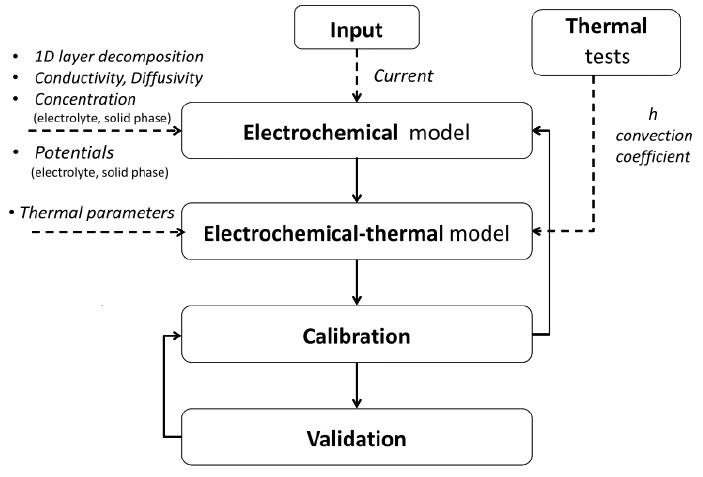
Figure 1. Methodology.